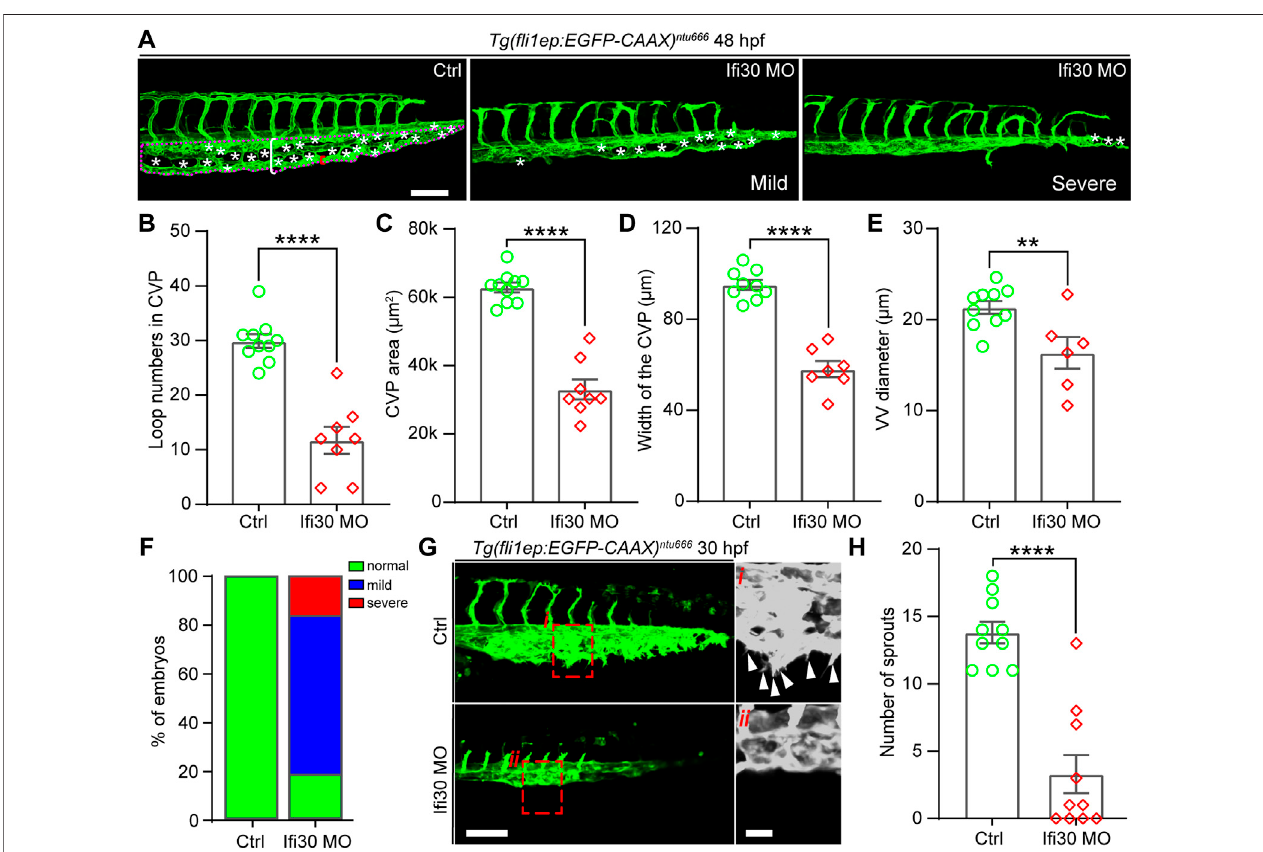
FIGURE 2 | I fi 30 knockdown leads to defective CVP morphogenesis in zebra fi sh embryos (A) Confocal images of CVP phenotypes in 48-hpf Tg ( fl i1ep:EGFP- CAAX ) ntu666 control embryos and embryos injected with I fi 30 morpholino (MO). The aberrant CVP phenotypes are de fi ned as mild and severe type, respectively (B – E) Quanti fi cation ofCVP loop numbers (asterisks), total CVP area (magenta dotted line outlined area), CVP width (white squarebracket), and ventral vein (VV) diameter (red square bracket) in control and I fi 30 morphants (F) The incidence of normal and defective CVP phenotypes in control Tg ( fl i1ep:EGFP-CAAX ) ntu666 embryos (n = 41) and I fi 30 morphant embryos (n = 40) (G) Confocal images of CVP region in control and I fi 30 morphants at 30 hpf. Right panels are the magni fi cations of the red dotted boxes. Arrowheads indicate the venous sprouts (H) Quanti fi cation of venous sprouts of CVP. Error bars represent SEM. **, p < 0.01. ****, p < 0.0001. Scale bars, 100